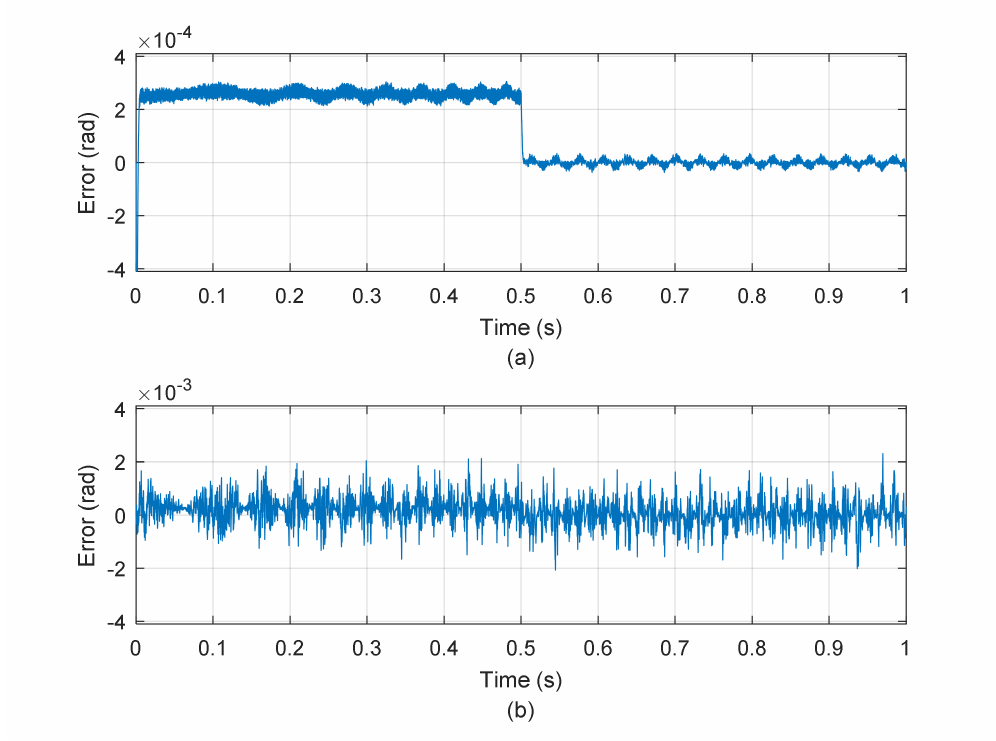
Figure 15. Experimental results for N p = 102, N c = 2, R w = 0.01. ( a ) Without noise; ( b ) with